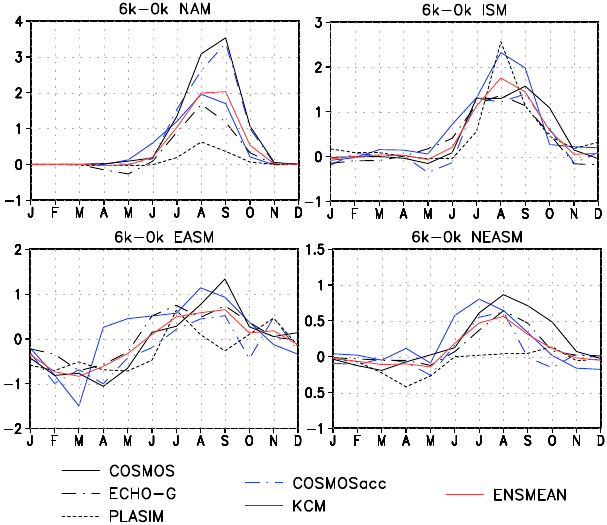
Figure 6. Simulated change in the seasonal precipitation cycle be- tween mid-Holocene and pre-industrial climate (mmday − 1 ) for dif- ferent regions in the Afro-Asian monsoon domain, i.e. the North African monsoon region (NAM), Indian monsoon region (ISM), East Asian monsoon region (EASM), and the northern part of the East Asian monsoon region (NEASM). Please note the change in